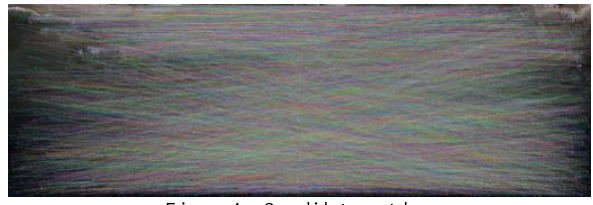
Figure 4c: Candidate matches